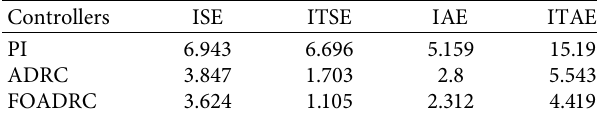
Table 2: Te error integral criteria of three controllers.